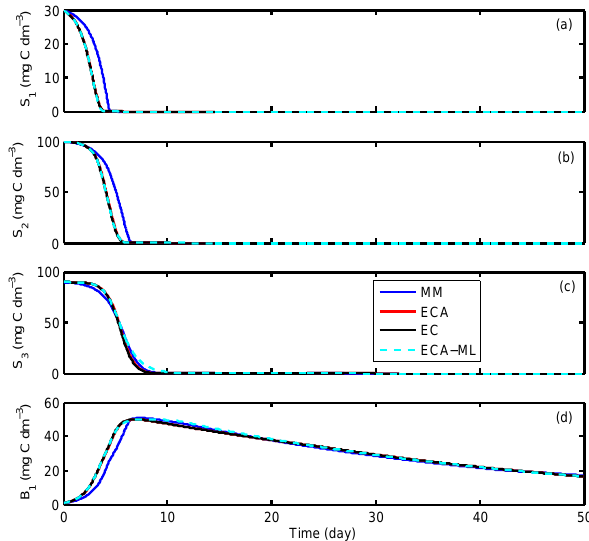
Fig. 4. Time series of the relevant state variables simulated from the applications of the four different substrates uptake kinetics to microbial model